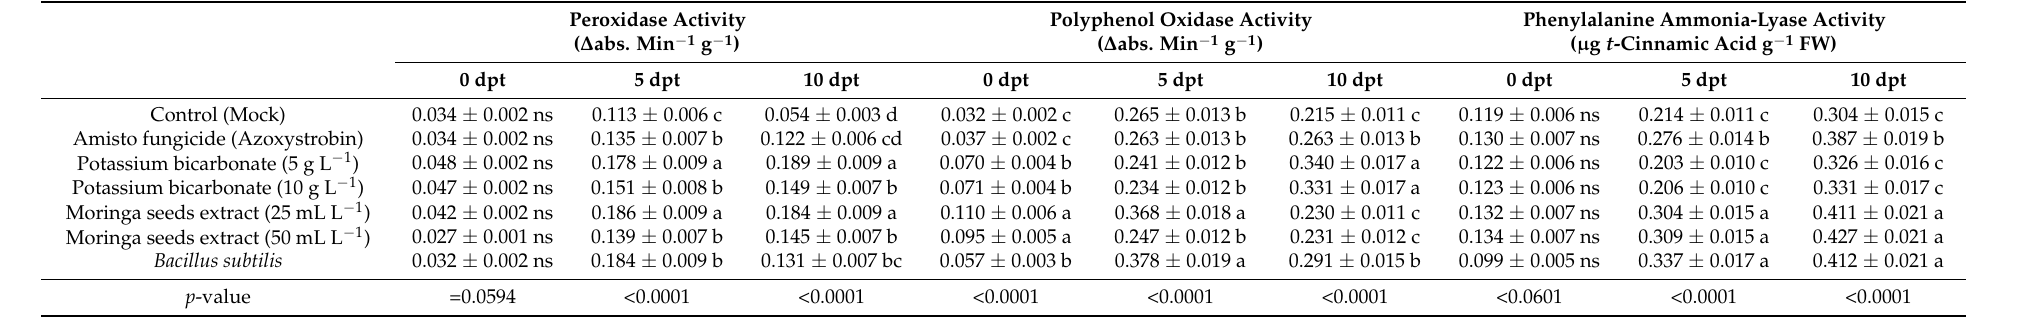
Table 2. Effect of different treatments on the enzymatic activity of peroxidase (POX; antioxidant enzyme), polyphenol oxidase (PPO; antioxidant enzyme), and phenylalanine ammonia-lyase (PAL; SA biosynthetic enzyme) of sugar beet plants infected with powdery mildew disease caused by Erysiphe betae under field conditions during the 2020 and 2021 seasons